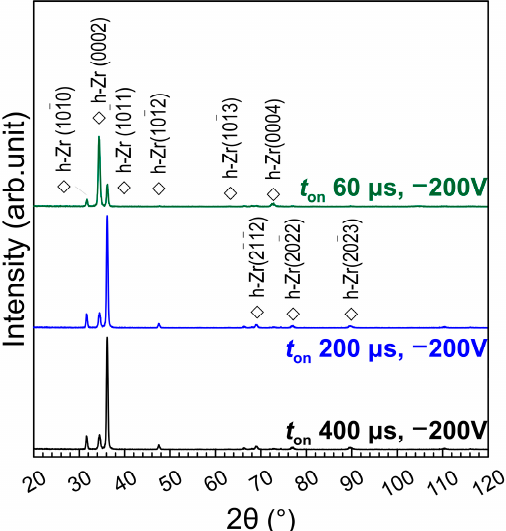
Figure 9. X-ray diffractograms of Zr films deposited at the argon pressure of 0.8 Pa and pulsed substrate bias of − 200 V with different HiPIMS pulse widths ( t on ).